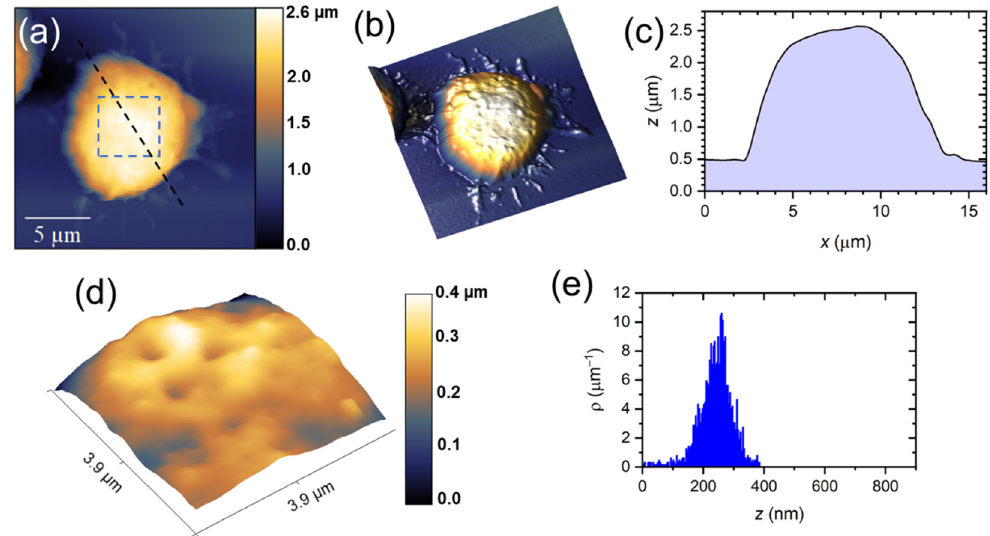
Figure 1. Representative AFM image of an acute lymphoblastic leukemia cell cultured on bare glass for 40 min. ( a ) Two- dimensional and ( b ) three-dimensional topography images, revealing pseudopods and microvilli structures. ( c ) Height profile taken along the dashed line in ( a ) showing the typical elliptical shape of the cell. ( d ) Three-dimensional representation of the zoomed area indicated by the dashed square in ( a ), revealing a corrugated membrane with pore-like structures. ( e ) Height distribution function calculated for the zoomed image shown in ( d ). The height z = 0 nm corresponds to the lowest height value within the zoomed region in ( d ).